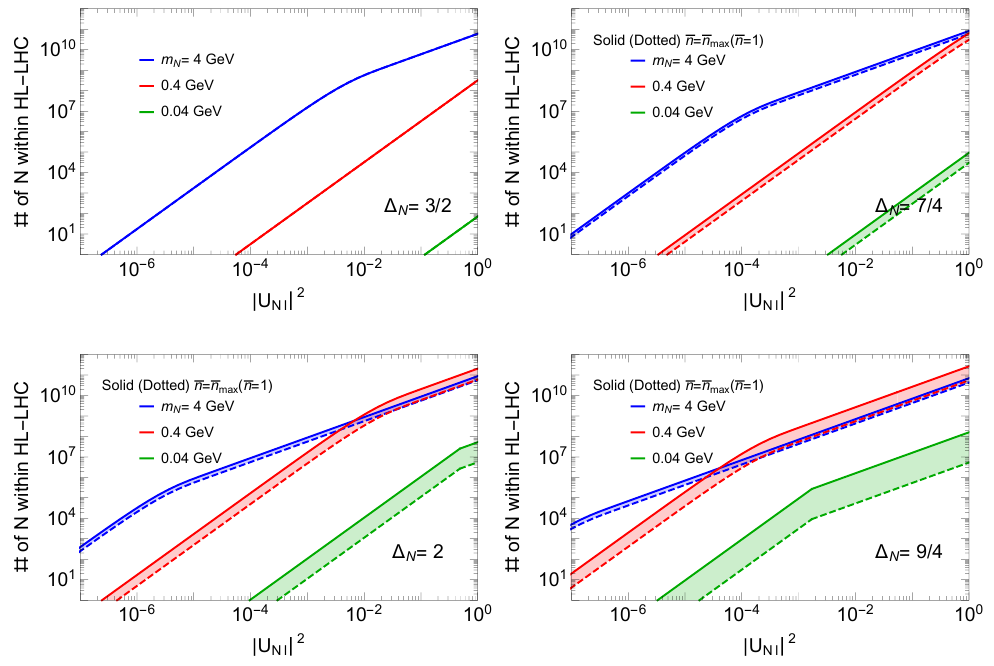
Figure 9 . The expected number of composite neutrinos decays at the HL-LHC for various bench- mark choices of the m and scaling dimensions ∆ . The solid or dashed lines show how the results N N vary by assuming each unparticle produced results in n or one singlet neutrino, max